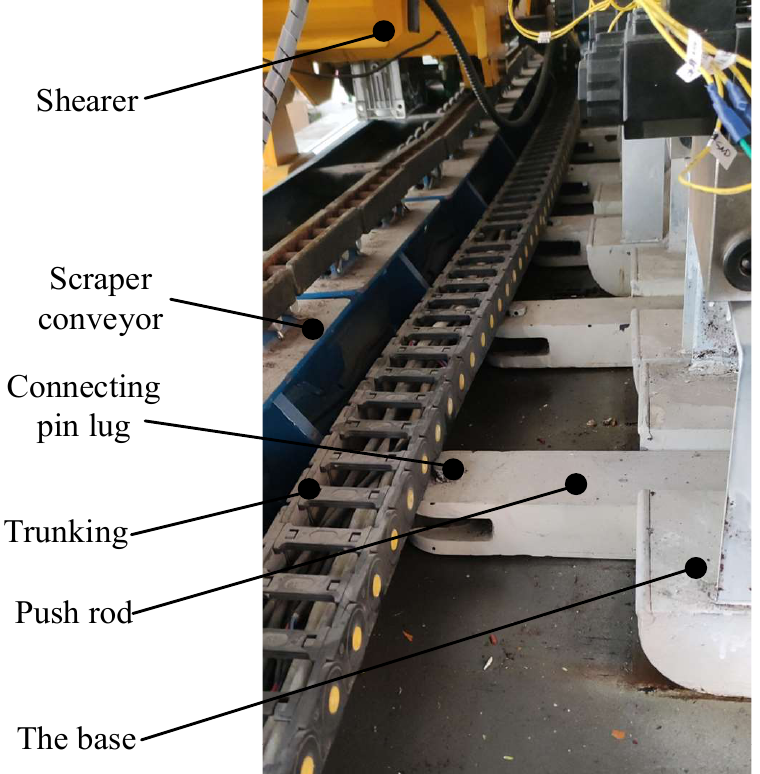
Figure 17. Sample collection experiment of the moving cylinder of hydraulic support.